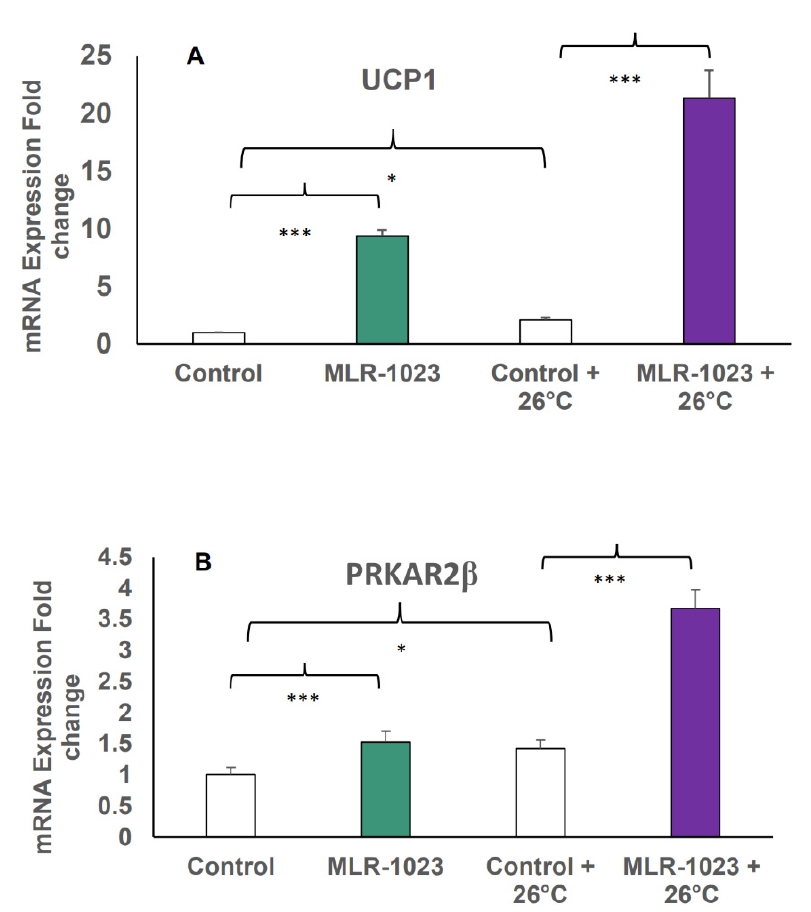
Figure 5. mRNA expression in human adipocytes (HASCs) treated with MLR-1023 and cold stimulation. qRT-PCR assays were conducted in duplicates following MLR-1023 (60 µM) treatment of human adipocytes from three obese donors (four technical replicates each) for seven days compared to untreated adipocytes (control), maintained at 37 °C, or treated as such and maintained at 26 °C for the last 24 h: ( A ) uncoupling protein 1 (UCP1) and ( B ) protein kinase cAMP-dependent type II regulatory subunit beta (PRKAR2 β ). The results are presented as mean ± SE. * p < 0.05, *** p ≤ 0.001 compared to the respective control.